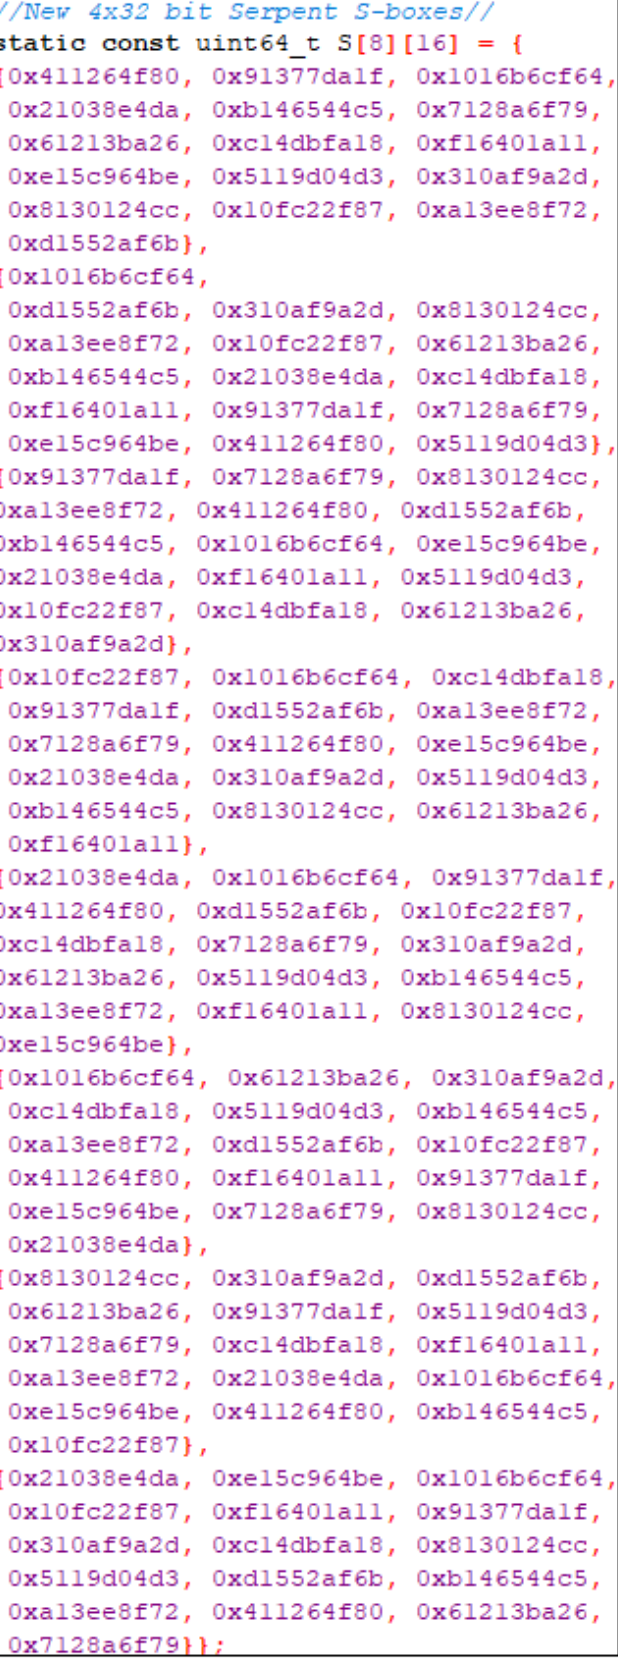
Figure 5. New 32-bit S-Boxes written in